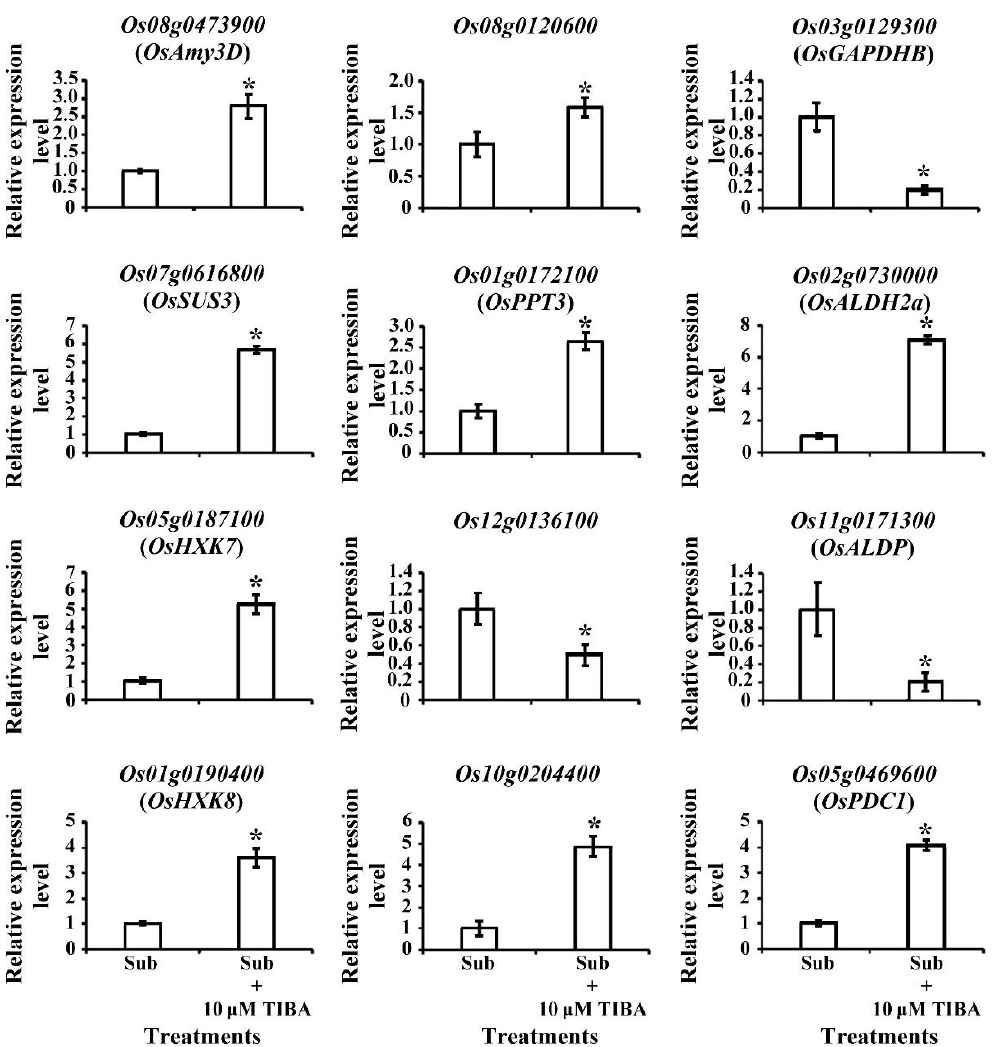
Figure 6. Transcript levels of glycolysis-pathway-associated genes in submerged coleoptiles with 10 µ M TIBA. Total RNA was isolated from the coleoptile after 5 days of submergence treatment with or without 10 µ M TIBA. The relative expression levels of glycolysis-pathway—associated genes were determined using quantitative RT-PCR. These genes were calculated and normalized with ubiquitin gene ( Os02g0634800 ) as an internal standard. Values are presented as mean ± standard deviation based on 30 coleoptiles of each treatment obtained from six biologically independent experiments. * p < 0.05 versus the submergence treatment value (Student’s t -test).